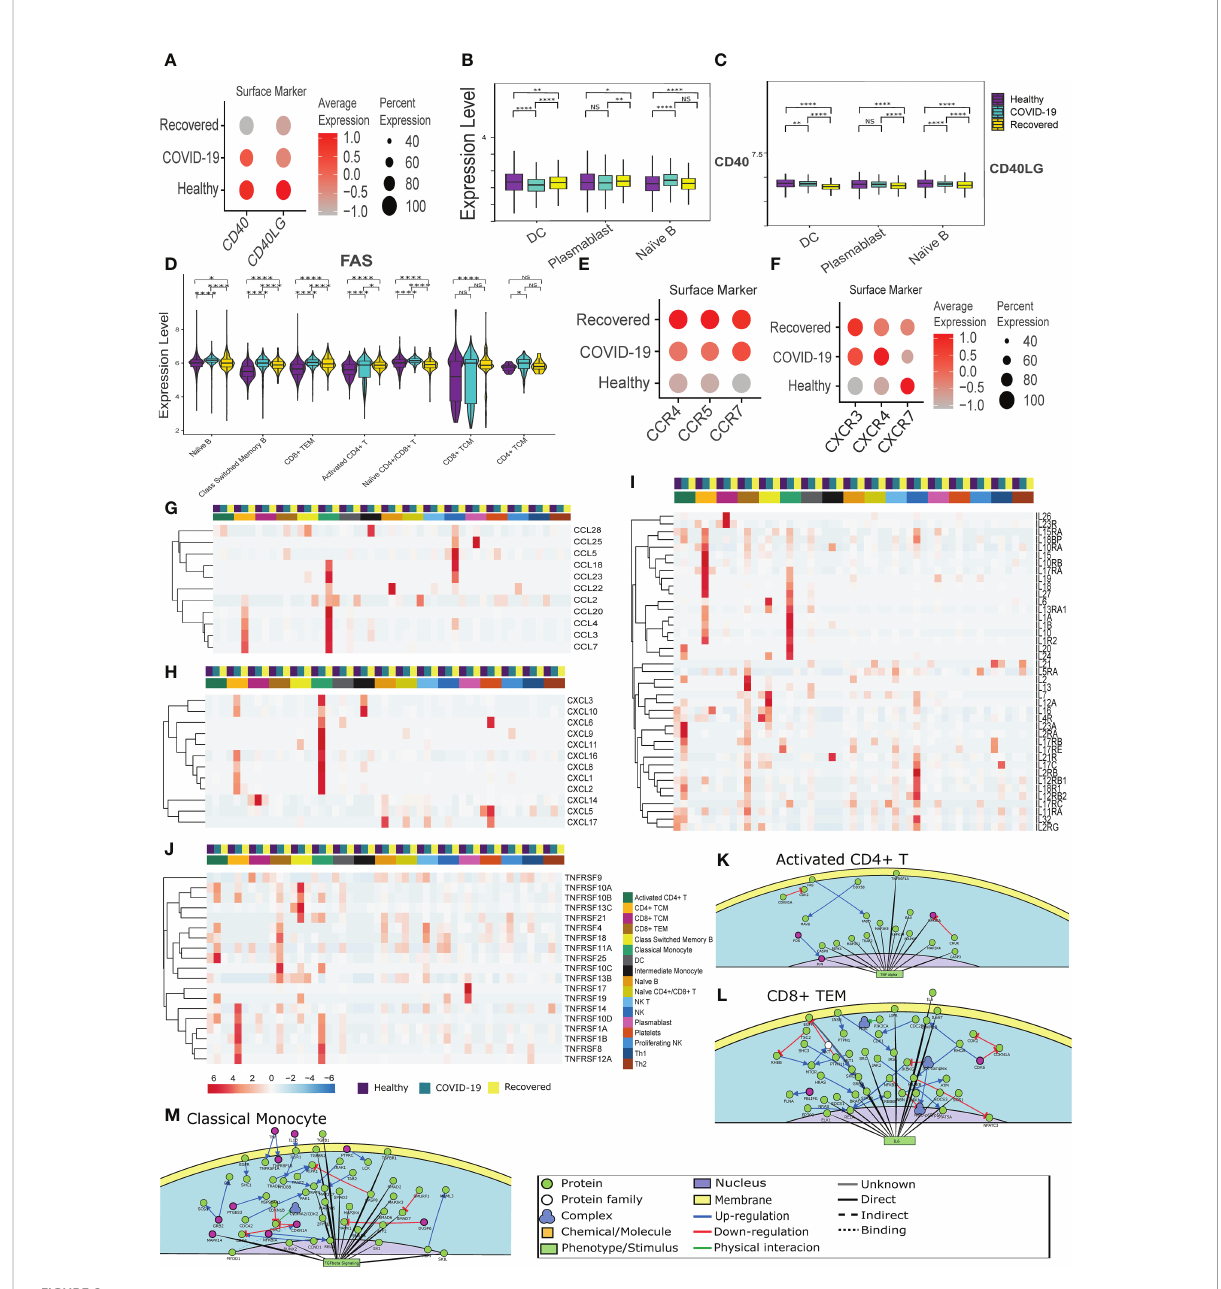
FIGURE 2 CD40-CD40LG mediated In fl ammatory response in the COVID-19 patients. (A) CD40-CD40LG expression at surface level across the three groups of COVID-19 active infection, healthy and the recovered individuals. Color scale denotes the relative expression whereas circle size denotes the percentage of cells expressing the marker. (B, C) Cell- type speci fi c surface expression of CD40-CD40LG across the 3 groups. (D) Surface level expression of FAS in the B and T cells. (E, F) Chemokine and Chemokine receptor expression at the surface level across the three groups. (G – J) RNA level expression of (G) Cytokines, (H) Chemokines, (I) Interleukins and (J) TNF Receptor Superfamily across all the cell types. (K – M) PPI level interaction network at (K) Activated CD4+ T cells, (L) CD8+ TCM, and (M) monocytes. [NS represents non-signi fi cant, *represents p-value < 0.05, **represents p-value < 0.01, **** represents p-value <